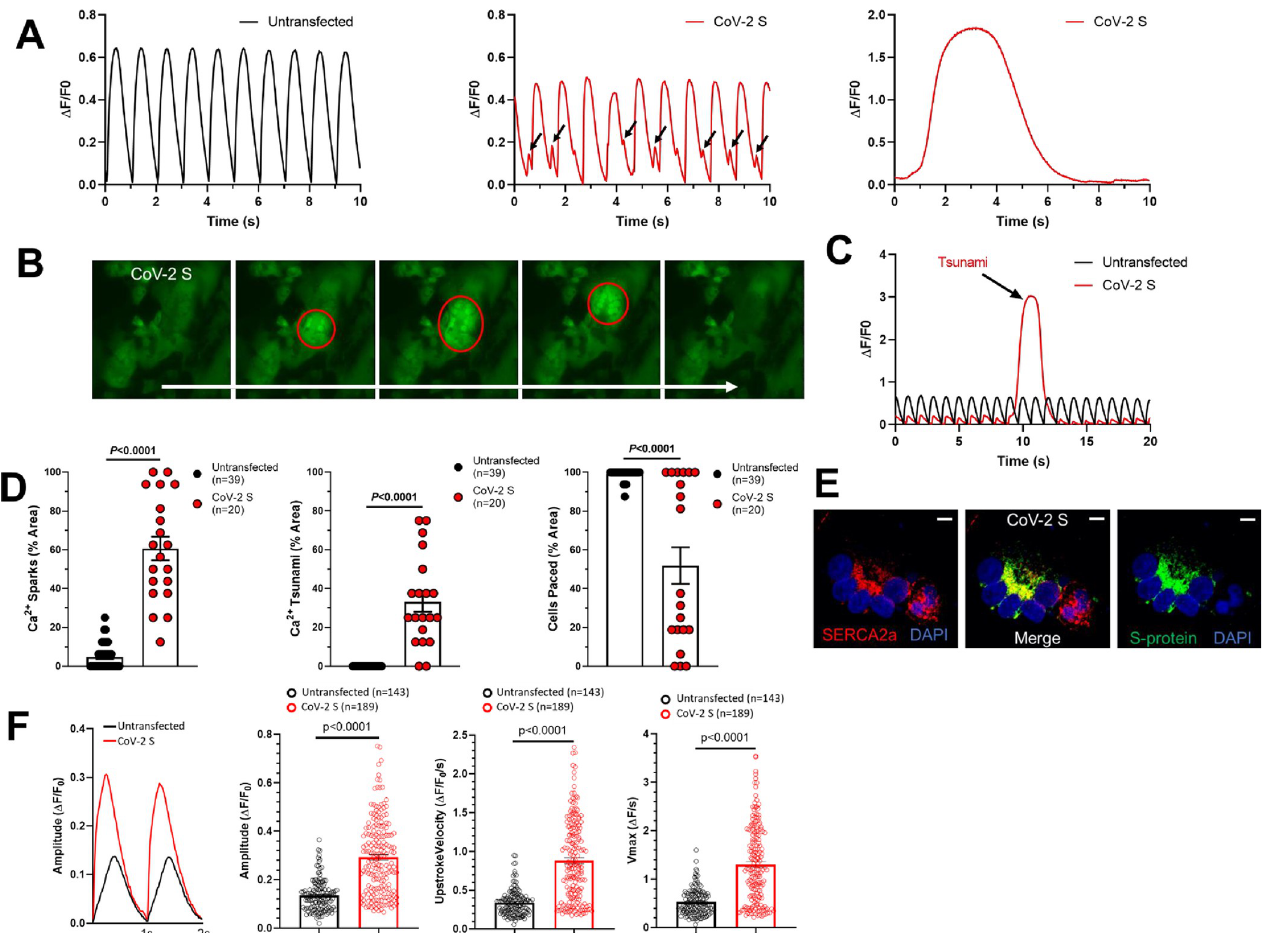
Fig 4. SARS-CoV-2 spike protein-induced hiPSC-CM syncytia display abnormal calcium handling. ( A ) Representative Fluo-4 calcium imaging traces derived from untransfected hiPSC-CMs (black) showing normal calcium transients (left) and from CoV-2 S-transfected hiPSC-CMs (red) showing calcium sparks (middle) and tsunamis (right). ( B ) Still frame images of Fluo-4 calcium imaging in CoV-2 S-transfected hiPSC-CMs. Red circles indicates the calcium tsunami. ( C ) Representative Fluo-4 calcium imaging traces comparing the amplitude and duration of a calcium tsunami in CoV-2 S-transfected hiPSC-CMs to normal calcium transients in untransfected hiPSC-CMs. ( D ) Quantification of calcium sparks (left), calcium tsunamis (middle), and pacing (right) in untransfected (n = 39) and CoV-2 S-transfected (n = 20) hiPSC-CMs. ( E ) Confocal immunofluorescence microscopy showing colocalization of SERCA2a and CoV-2 S. Scale bars 10 μ m. ( F ) Representative Fluo-4 calcium imaging traces and data summary graphs derived from untransfected hiPSC-CMs (black, n = 143) showing normal calcium transients and from CoV-2 S-transfected hiPSC-CMs (red, n = 189) showing increased amplitude, upstroke velocity and Vmax of calcium transient. Graphs are presented as mean ± SEM. Unpaired two-tailed Student’s t-tests were conducted to determine significance.